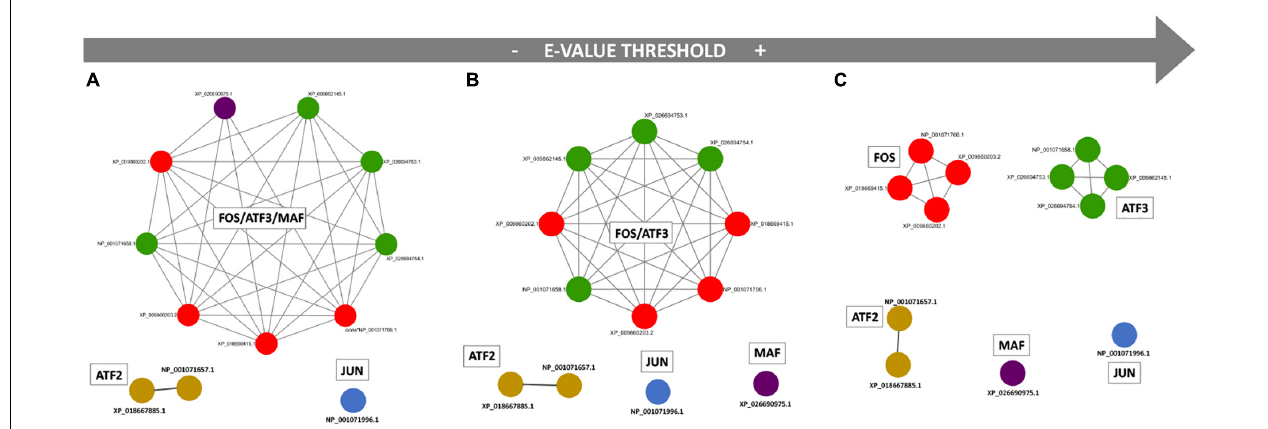
FIGURE 1 | Ciona robusta bZIP members related to Jun and Fos when similarity threshold changes. Networks of paralogs were detected at different e -value thresholds: (A) e − 10 ; (B) e − 15 ; (C) e − 30 . Each node in the network represents a protein, and each gray edge represents a paralogy relationship. FOS member isoforms are shown in red, ATF3 in green, ATF2 in light brown, MAF in purple, JUN in blue.